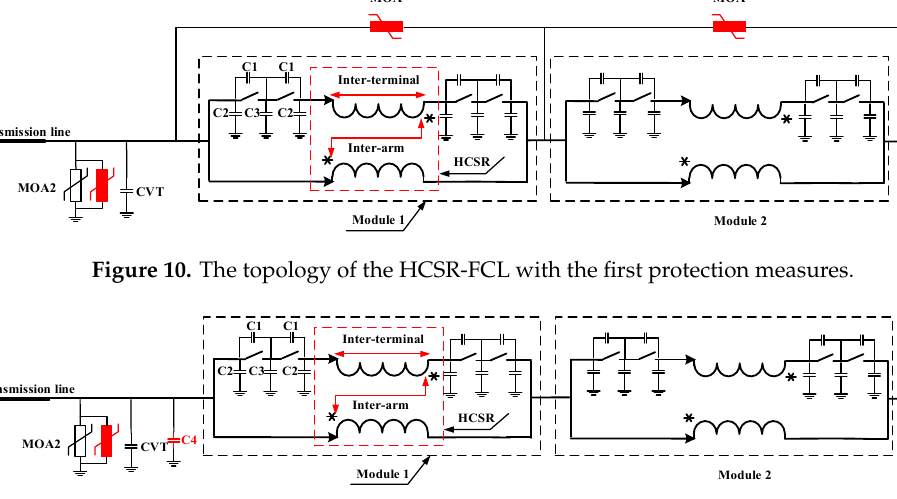
Figure 11. The topology of the HCSR-FCL with the second protection measures.